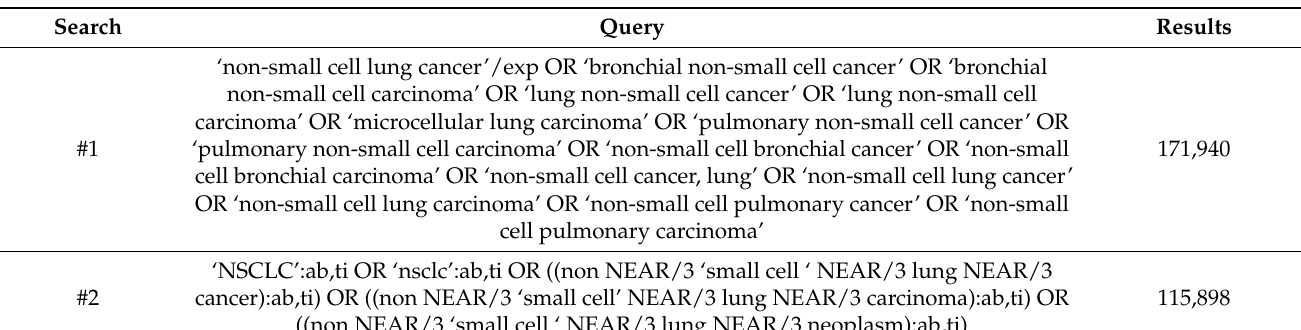
Table A1. Search strategy in